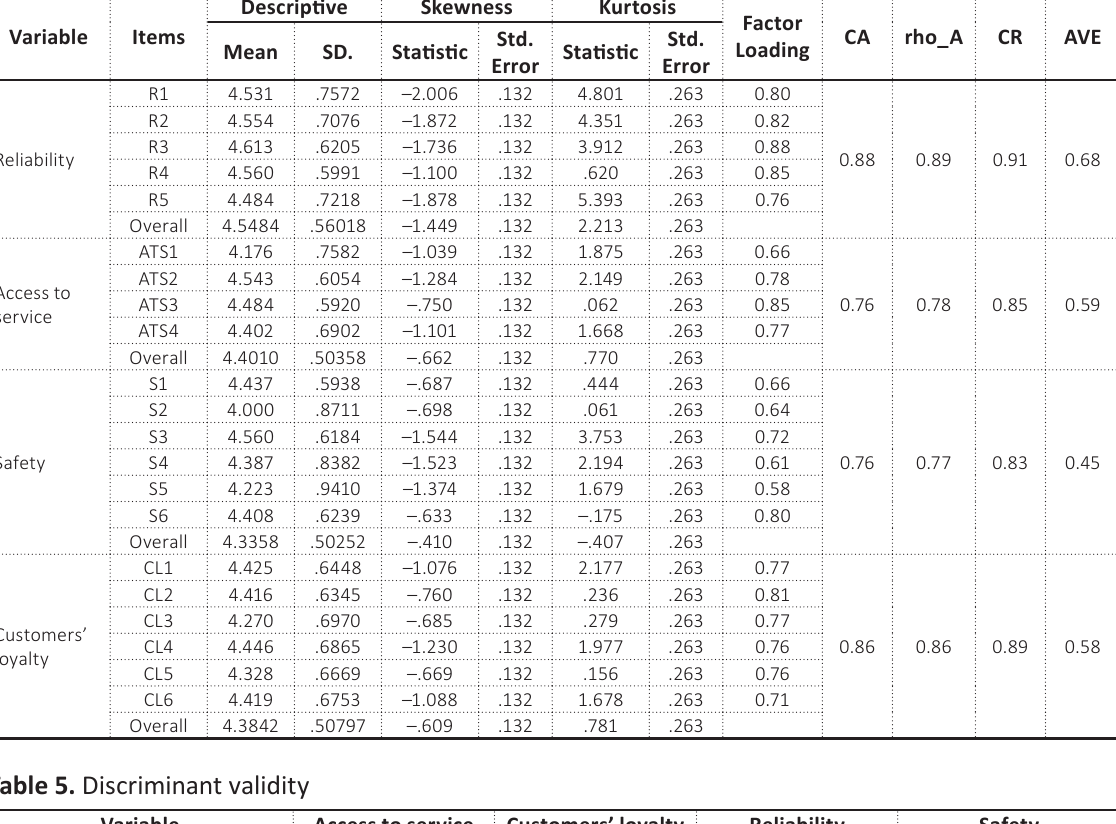
Table 4. Validity and reliability of constructs Variable